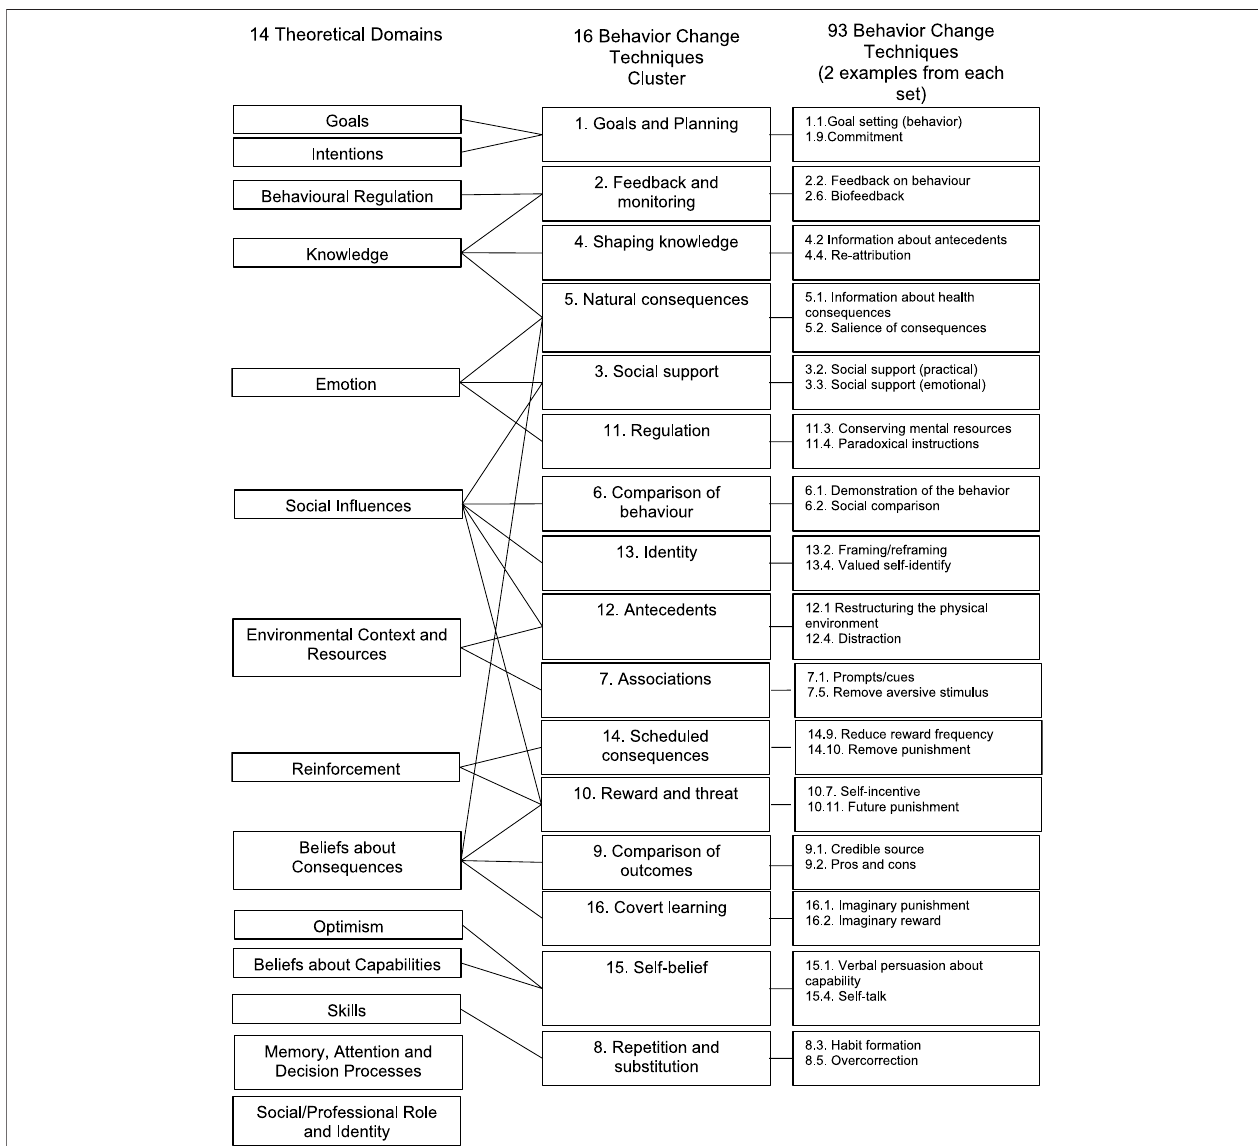
FIGURE1| RecommendedconnectionsbetweentheBehaviorChangeTechniquesversion1,TechniqueClusters,andTheoreticalDomainsFrameworkDomains.